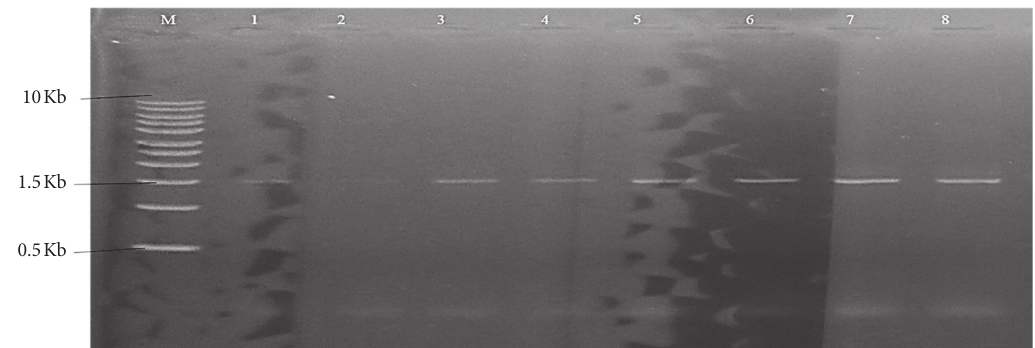
Figure 5: Amplification of bacterial 16S rRNA gene. M is the molecular marker (1kb plus ladder); lane 1, isolate KVS68; 2, KMP45; 3, KC75; 4, TS380; 5, KVS214; 6, KFR38; 7, KS376; 8, KMP253.